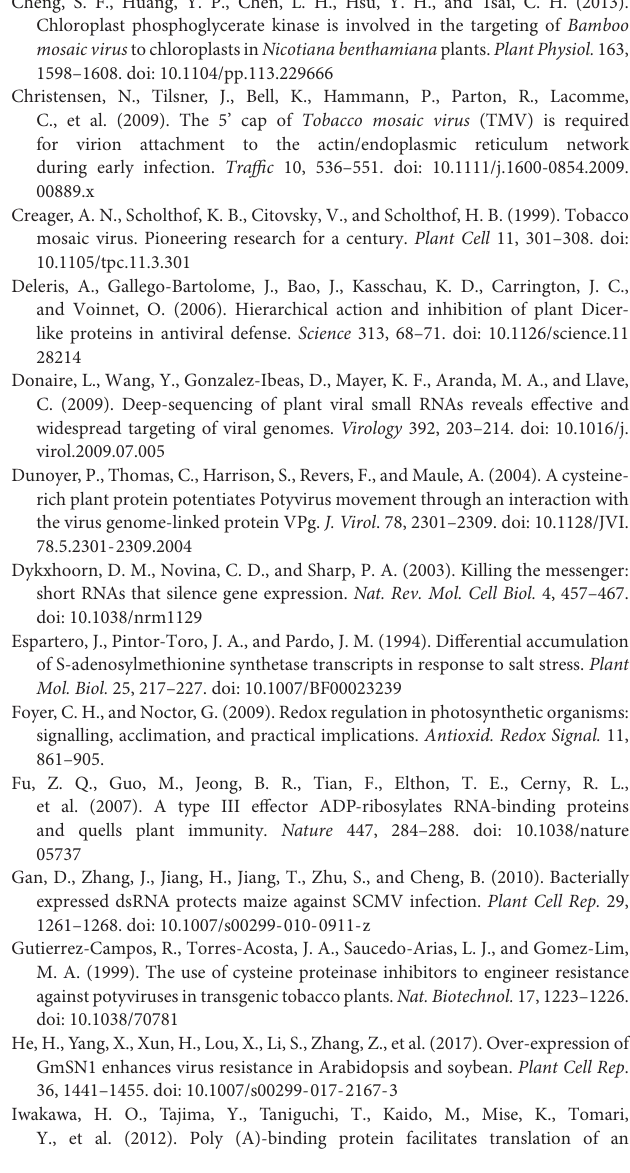
Supplementary Figure 3 | Similar pattern of dsRNAp126-derived and TMV-derived siRNA production in dsRNAp126 and TMV treatments, respectively. Supplementary Figure 4 | Non-protective effect of non-homologous dsRNAHC (deriving from HC-Pro of Zucchini yellow mosaic virus ) against TMV in tobacco.